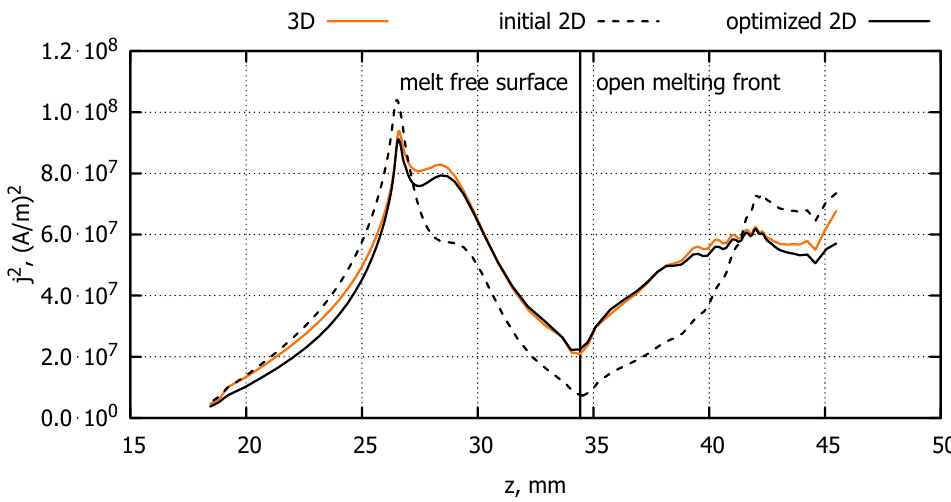
Figure 6. Comparison of induced currents on silicon surfaces in the case of 2D and 3D